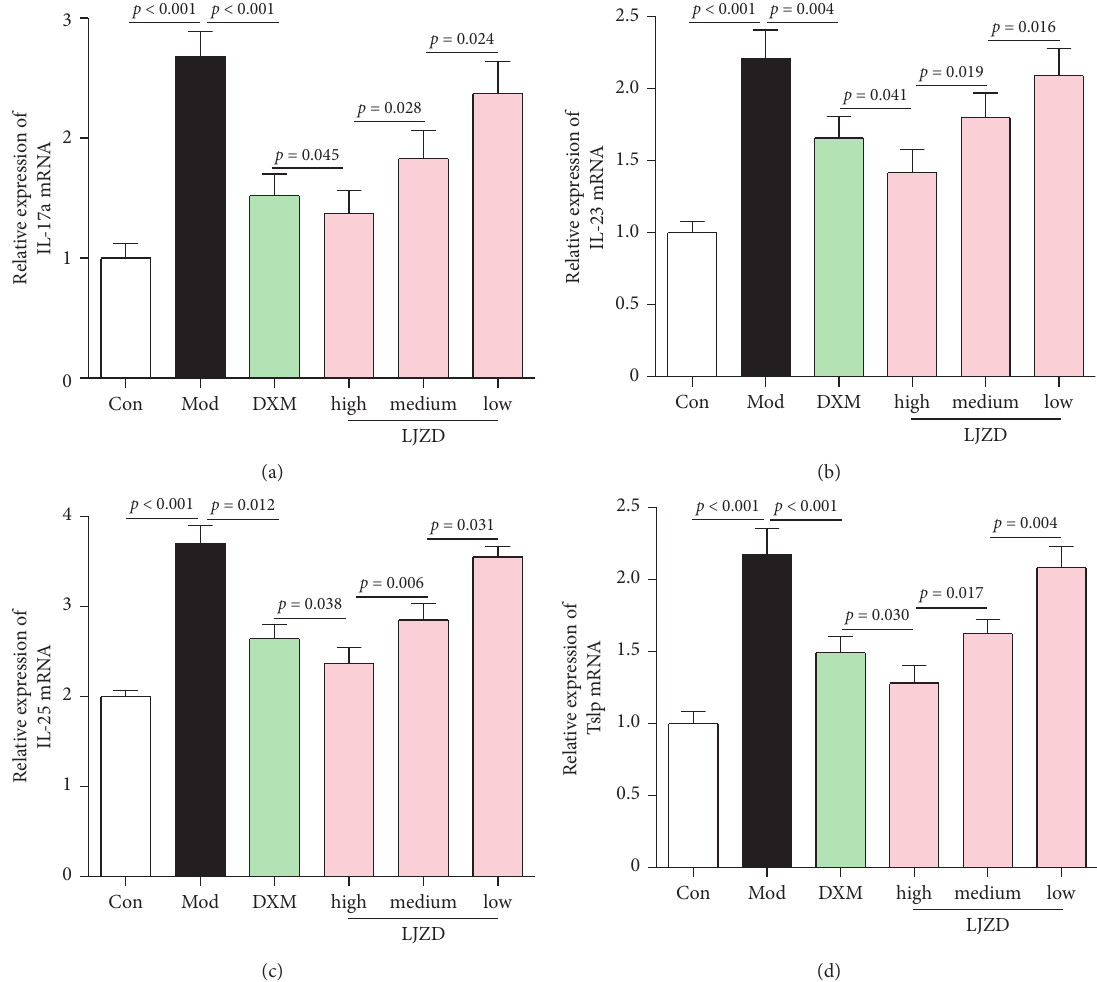
Figure 4: LJZD reduced the mRNA expression levels of IL-17a (a), IL-23 (b), IL-25 (c), and Tslp (d) in lung tissues of asthmatic mice by real- time PCR. Data were expressed as the mean ± SD ( n � 3). Tslp: thymic stromal